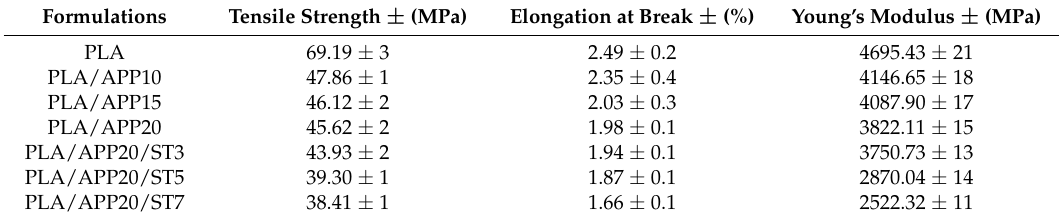
Table 4. Mechanical properties of PLA, PLA/APP, and PLA/APP/ST composites.